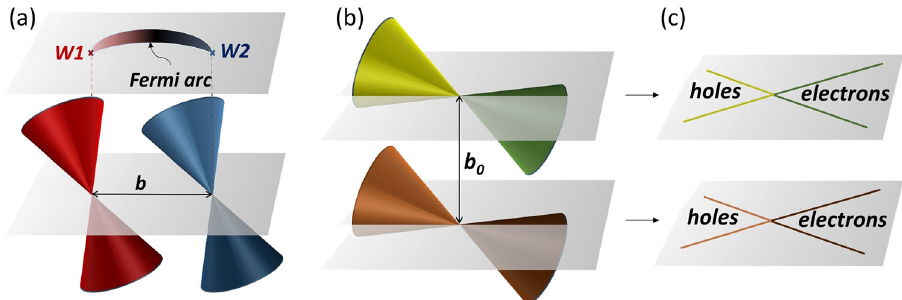
Fig. 1 Graphical representation of the electronic structure of Weyl semimetals. a Separated cones in momentum space by b with tilting Ψ < 1. The projected bulk Weyl nodes on the surface of the crystal lead to Fermi arc surface states; b Separated cones in energy space by b 0 with tilting Ψ > 1; c The severe tilting of the cones results in electron and hole states residing on the